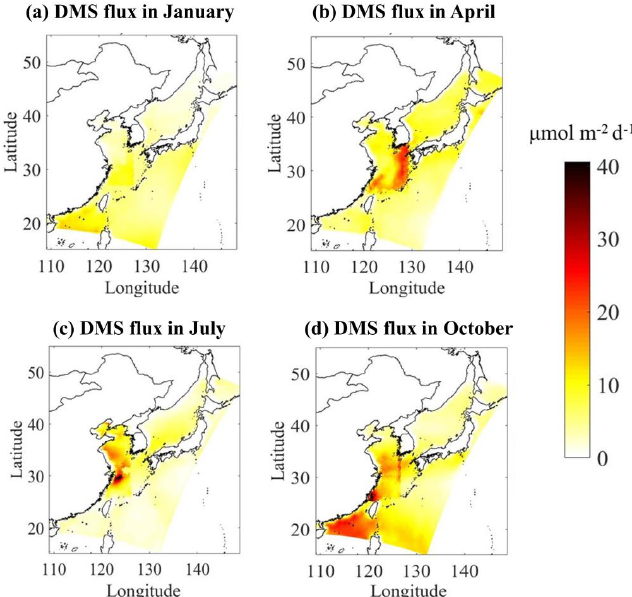
Figure 3. The spatial distribution of DMS sea-to-air emission fluxes with LM86 (Liss and Merlivat, 1986) parameterization scheme in four typical months of ( a ) January, ( b ) April, ( c ) July, and ( d )